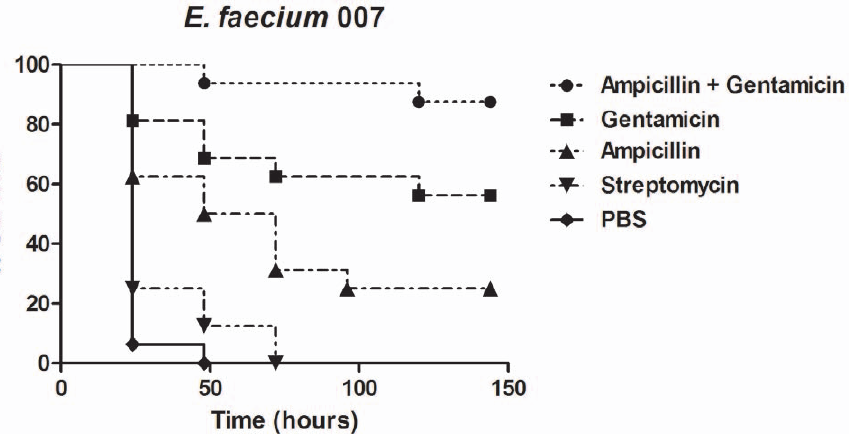
Figure 3. Antimicrobial drugs prolong the survival of G.mellonella caterpillars infected by E.faecium. We examined the role of the most commonly used agents (alone or in association) for enterococcal infection by administering single doses of ampicillin, gentamicin, streptomycin and the association of ampicillin and gentamicin. The antibiotics were administered within 2 h after larvae were infected with 5.6 6 10 7 CFU/larva of E. faecium E007. A control group received the E. faecium E007 inoculum and PBS instead of antibiotics. Treatment with ampicillin ( P =0.0003), gentamicin ( P =0.0001) and the combination of ampicillin and gentamicin ( P =0.0001) significantly prolonged the survival of G. mellonella caterpillars when compared to control. However, streptomycin was not effective against E. faecium E007 ( P =0.0995). A representative example was used for each group.